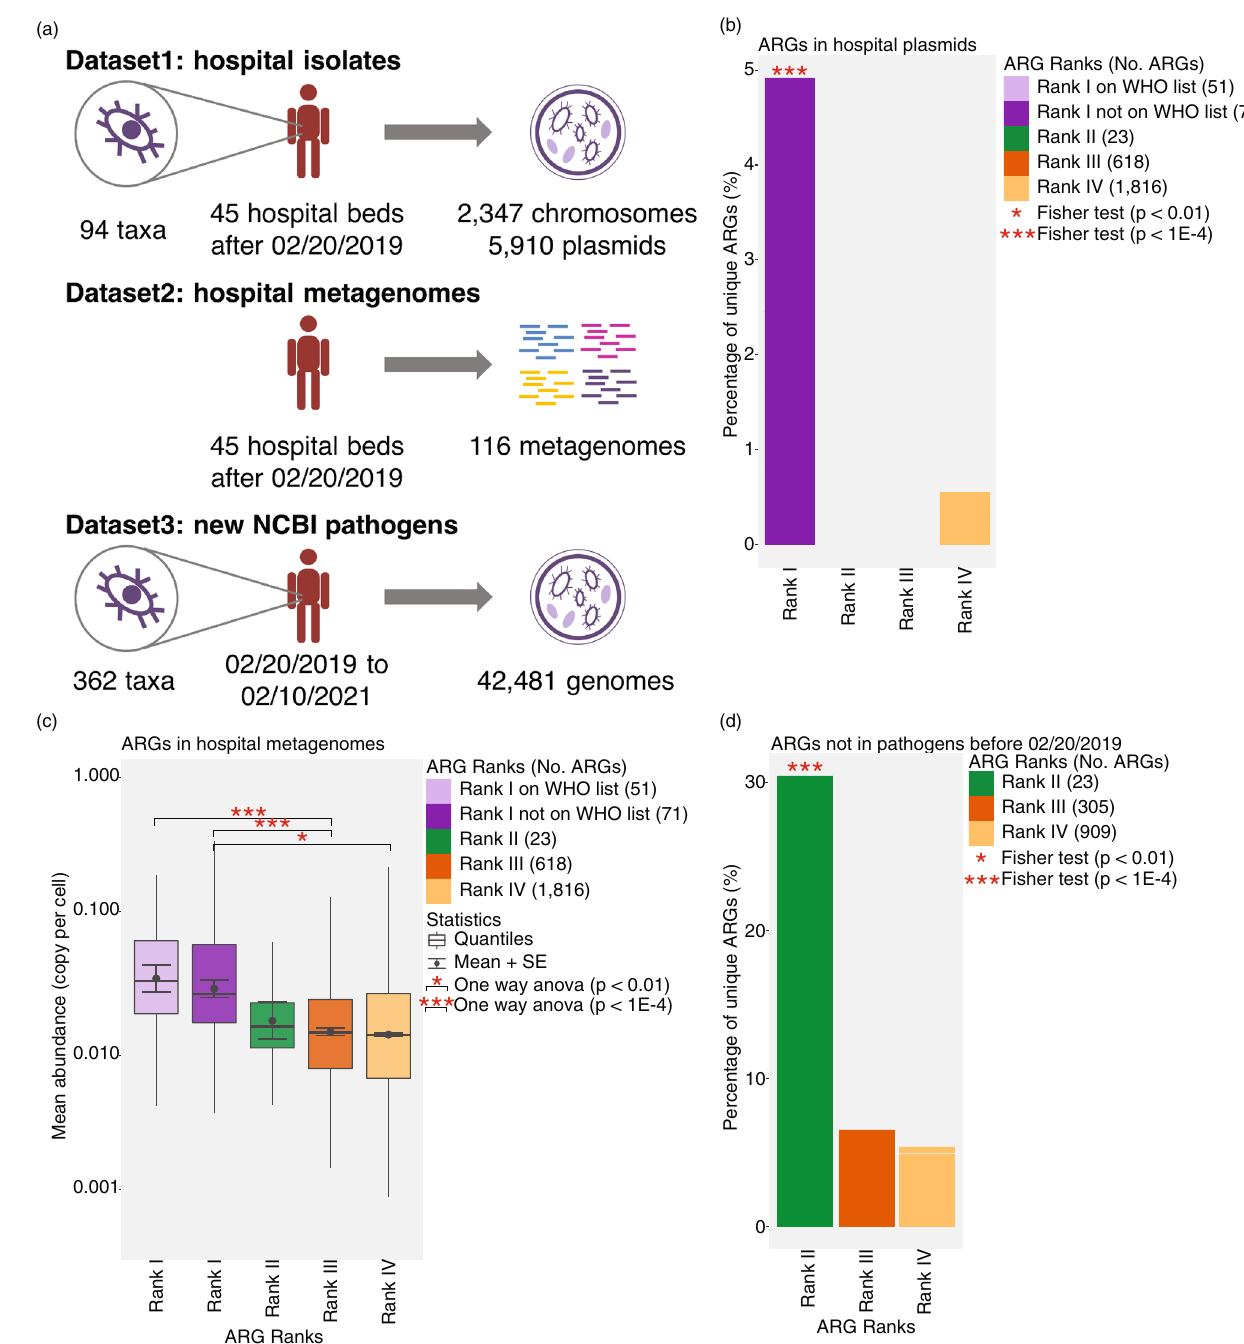
Fig. 4 Validation of the framework in this study by three clinical datasets collected after the initial analysis between 02/20/2019 to 02/10/2021 as the training datasets were collected on 02/19/2019. a The content of three datasets. Dataset1 contains the chromosomal genomes and plasmids collected from opportunistic pathogen isolates cultured from a tertiary hospital after 02/20/2019. Dataset1 covers a total of 94 taxa (2,347 chromosomal genomes and 5,910 plasmids). Dataset2 contains 116 metagenomes collected after 02/20/2019 from a tertiary hospital. Dataset3 contains all NCBI pathogen genomes submitted in the last 2 years (02/20/2019 to 02/10/2021). Dataset3 covers a total of 362 taxa (42,481 genomes). ARG sequences of the initial set were searched in three testing datasets using the same criteria described before (90% aa similarity over 80% aa hit length). b the percentage of unique ARGs of different Ranks in hospital plasmids. Asterisk of box represent the p value for fi sher exact test. n = 16 (No. of unique ARGs). c The mean abundance of ARGs of different Ranks in 116 hospital metagenomes. Quantiles (represented as bars), mean (represented as points), and standard error (represented as error bars) were computed for all ARGs in an ARG Rank. Asterisk of box represent the p value for one way anova test. n = 1393 (No. of unique ARGs detected in hospital metagenomes). Adjustments were made for multiple comparisons. Data are presented as mean values ± SE (error bars), median values (center of box), and 25%, 75% percentiles (bounds of box). The minima and maxima represent the range of the data. d The percentage of unique ARGs that were found in pathogens after 02/20/2019 and were not detected in pathogens before 02/20/2019. Asterisk of box represent the p value for fi sher exact test. n = 76 (No. of unique ARGs newly present in pathogens). Adjustments were made for multiple comparisons. The color represents the rank of ARGs (Rank I on WHO list, Rank I not on WHO list, Rank II-IV). ARGs antibiotic resistance